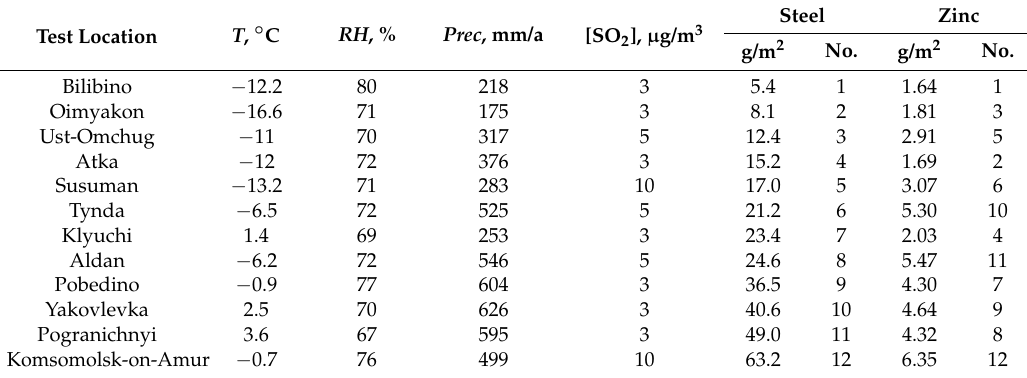
Table 4. Atmosphere corrosivity parameters of test locations and first-year corrosion losses of carbon steel and zinc ( K 1 , g/m 2 ) in Russian Federation test locations and their numbers in the order of increasing K 1 .